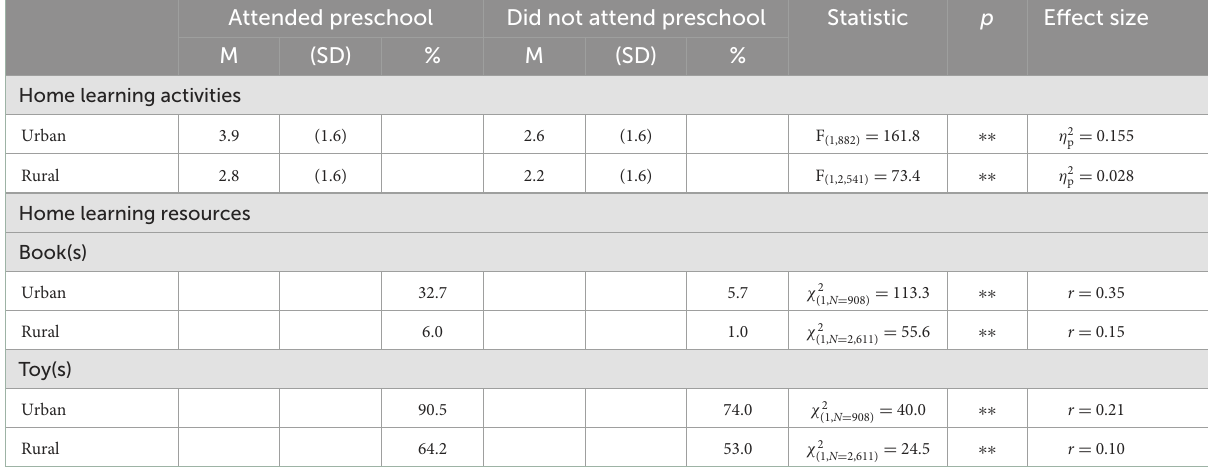
TABLE 6 Home learning resources and activities for 36- to 59-month-old children in Côte d’Ivoire who did and did not attend preschool. Attended preschool Did not attend